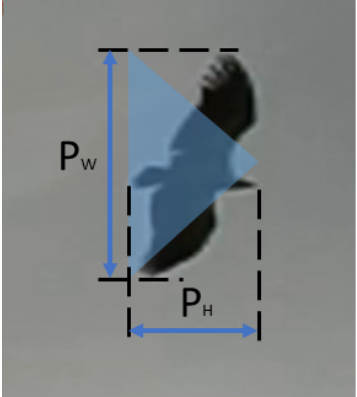
Figure 8. Graphical illustration of the bird’s size